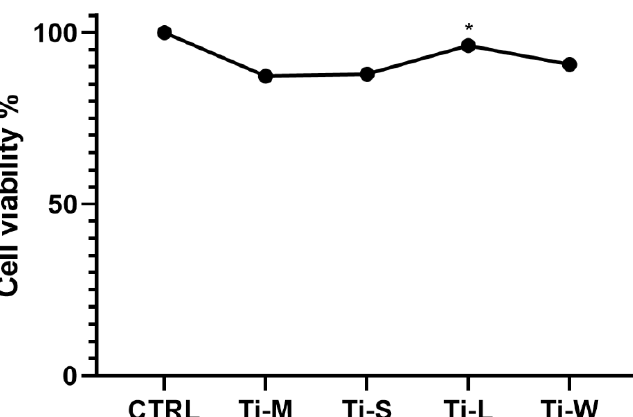
Figure 7. Effect of surface topography on hGDFs’ viability after 24 h of culture. More than 90% of cell viability was observed within all groups (* denotes the difference between the machined and sand-basted/dual-etched group, p < 0.05). There was no significant difference between the two surfaces with macrogeometry Ti-L and Ti-W.